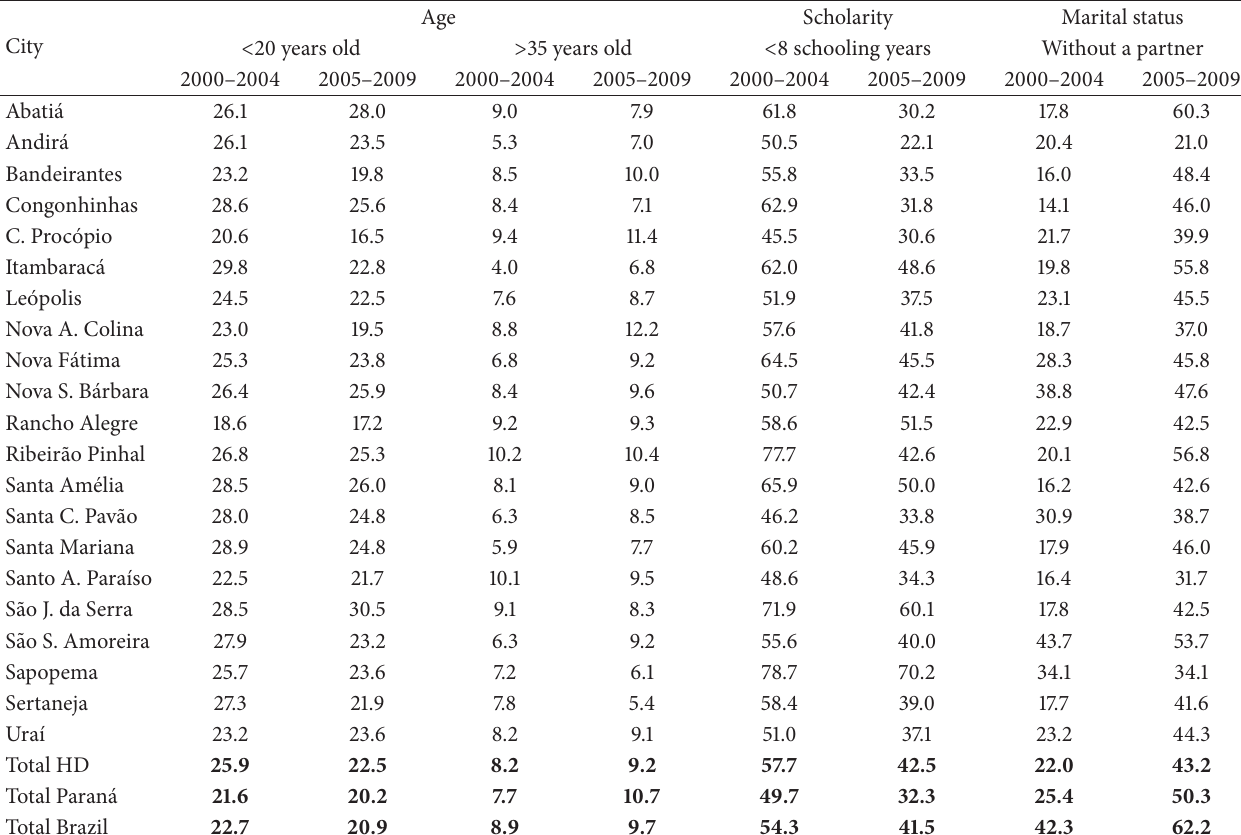
Table 2: Distribution of percentage means according to maternal variables, 18th HD, Paran´a, and Brazil, from 2000 to 2004 and 2005 to 2009. Age Scholarity Marital status < 20 years old > 35 years old < 8 schooling years Without a City